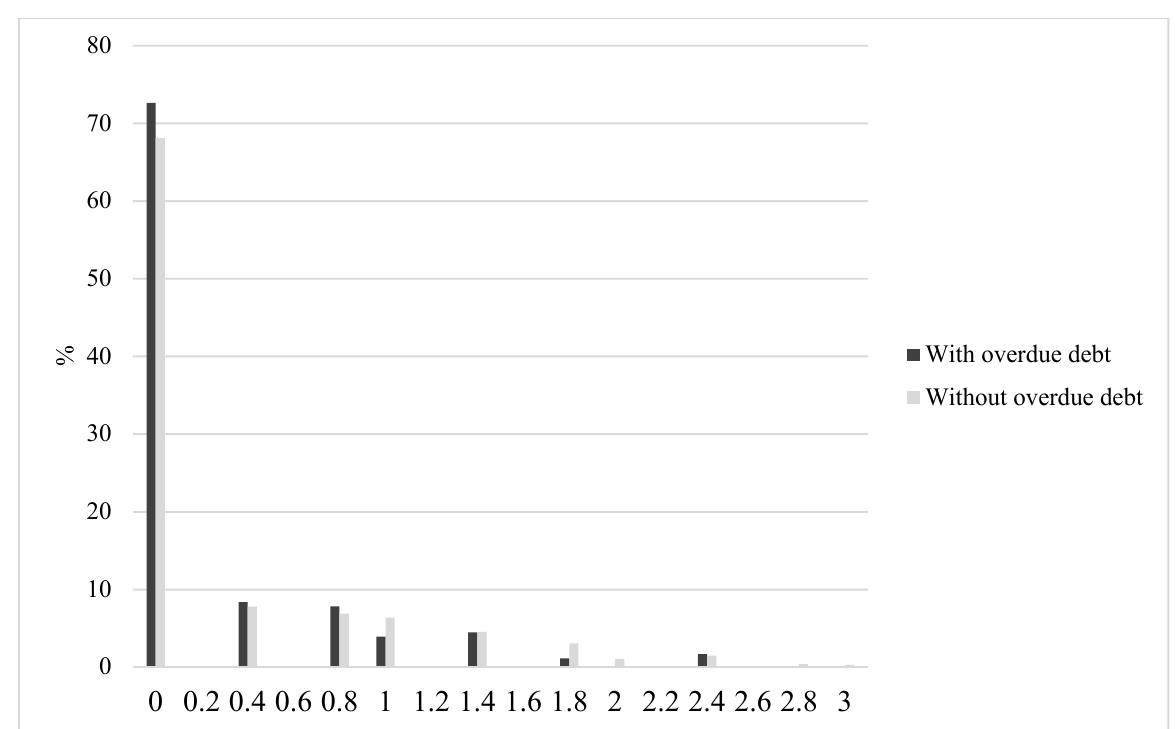
Figure 5. Distributions of the perceived social aversion to overdue debts in the subsamples with and without overdue debts. Source: Questionnaire-based survey, small settlements of BAZ County, Hungary, 2019.